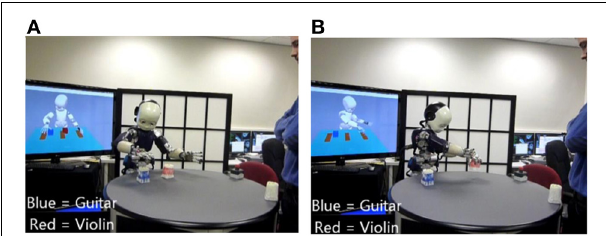
FIGURE 6 | Action Performing task. The robot is performing the motor commands corresponding to the sentence “Point the guitar before you put on the left the violin.” (A) the robot is pointing “guitar” (blue object), (B) the robot is finishing the displacement of the “violin” (red object).